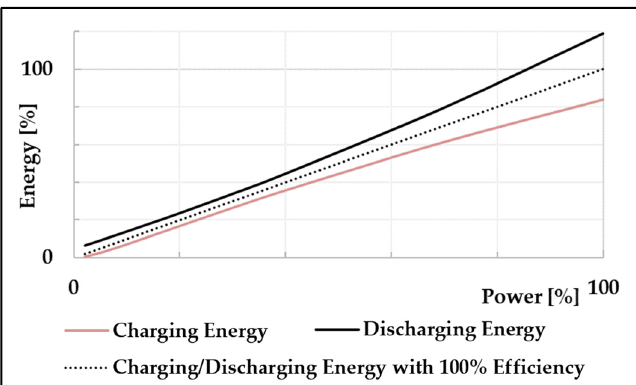
Figure 3. Charging/discharging energies based on function F tch and F tdis